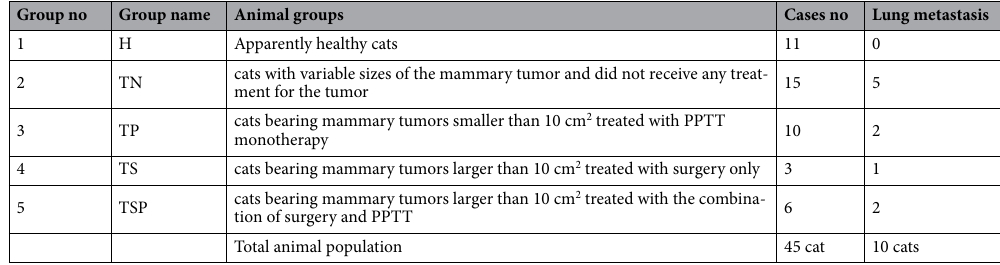
Table 1. Animal groups. (TN) tumor-no treatment, (TP) tumor-PPTT alone, (TS) tumor-surgery alone, (TSP) tumor-surgery, and